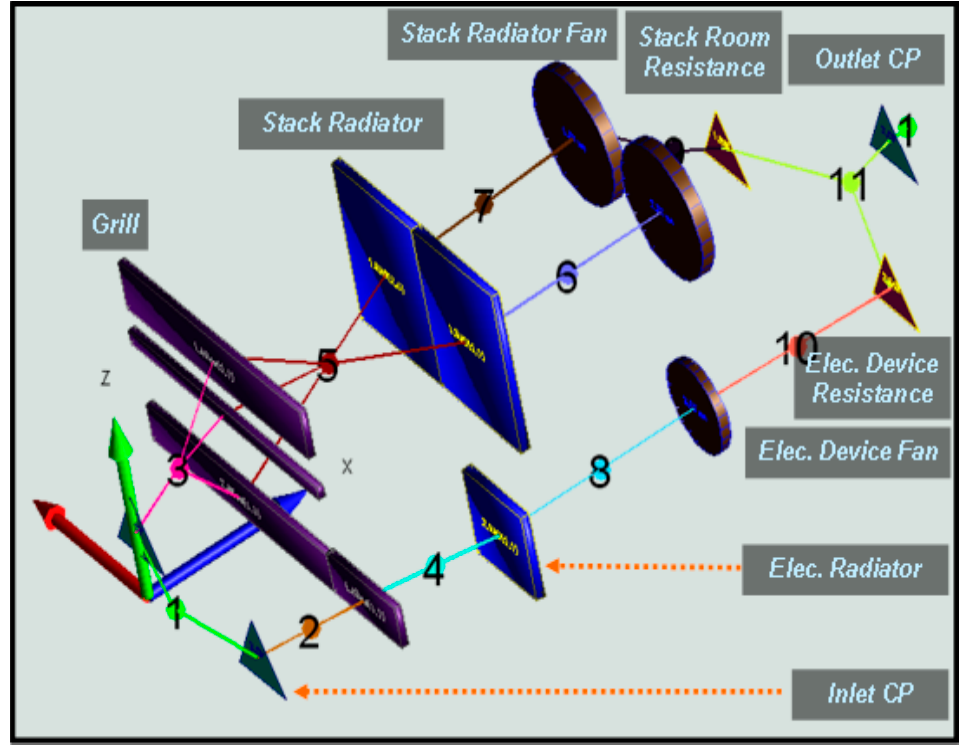
Figure 2. 1 ‐ D modeling, as performed by using the KULI program, of the stack cooling system. Figure 2. 1-D modeling, as performed by using the KULI program, of the stack cooling Table 3. Parameters used during simulation of the stack cooling system.